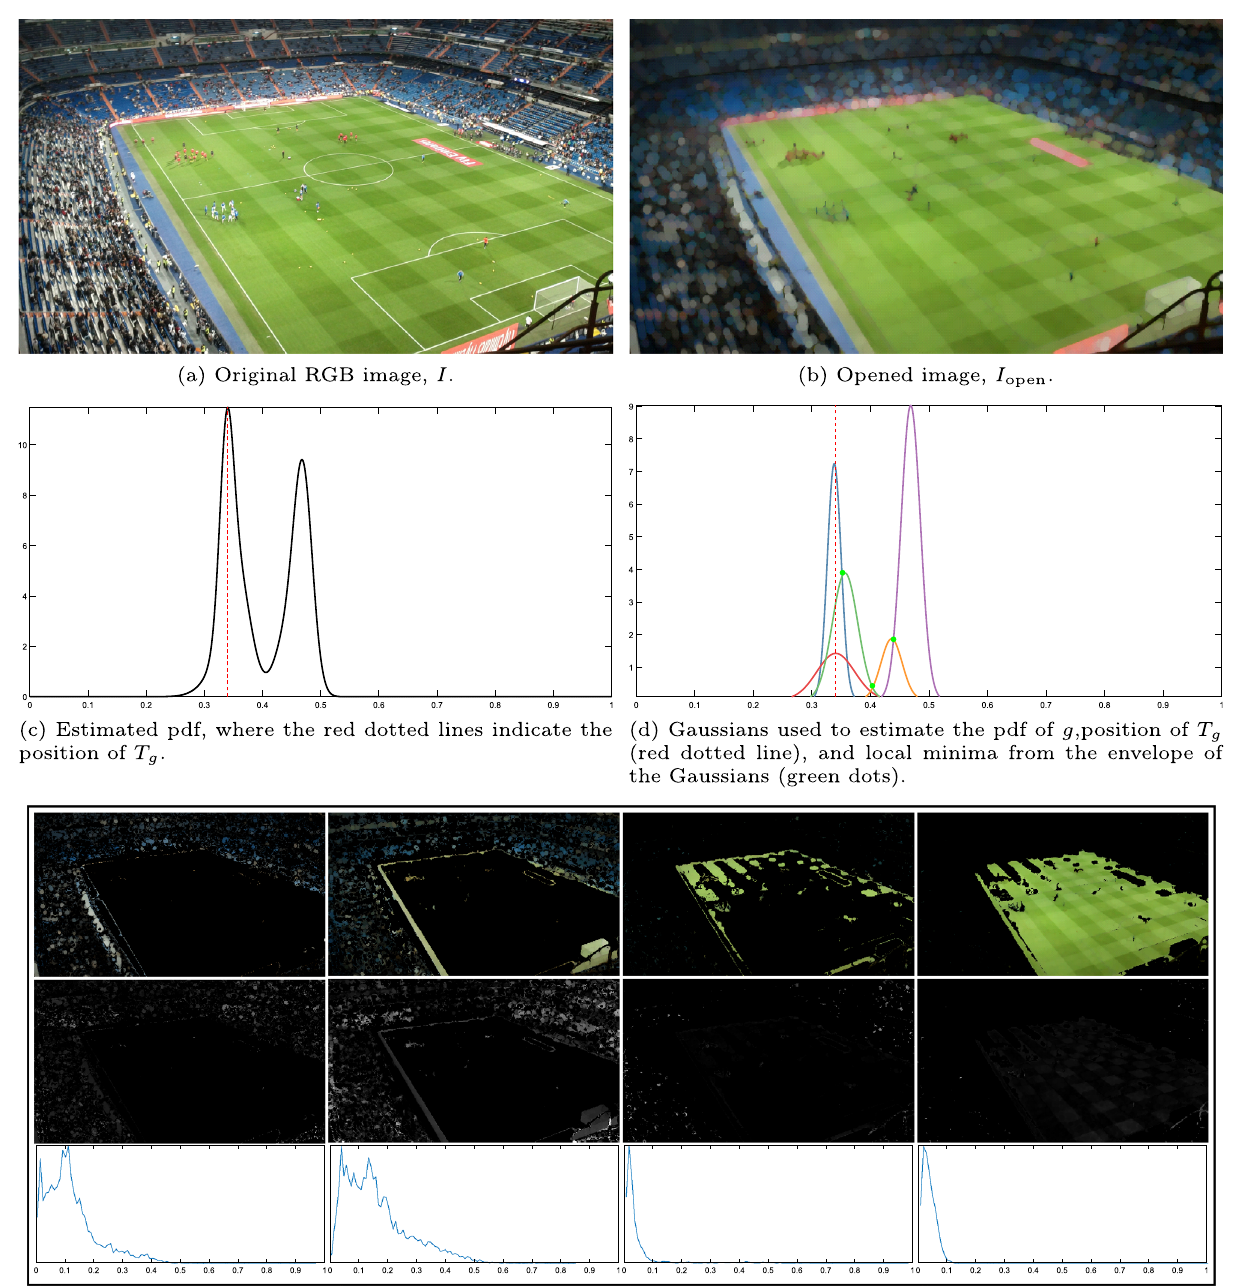
Figure 6. Analysis of the histograms of the chromatic distortion values. Original image from 46